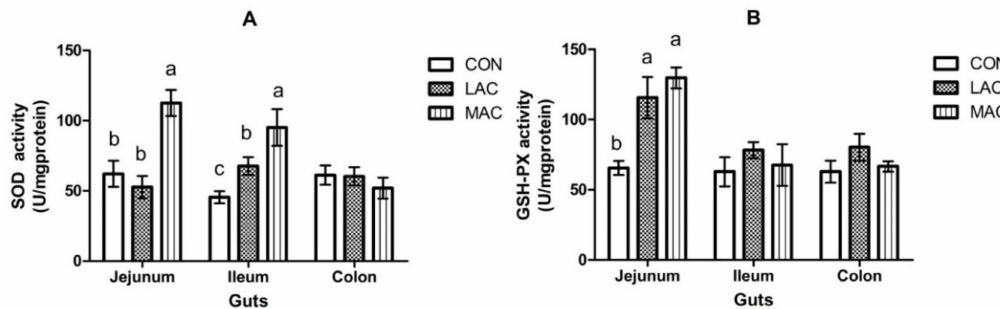
Figure 3. E ff ects of supplementing probiotics and prebiotics additives on the content (nmol / mg · protein) of MDA in the colon, ileum, and jejunum of young goats (Exp. 2). CON = control group; LAC = a control diet supplementing with 10 g / day Lactobacillus plantarum P-8; MAC = a control diet supplementing with 0.3 g / day plant extract (Sangrovit ® , MAC extract 3.75% w / w premix). a, b Row means that do not have a common superscript di ff er ( p < 0.05).